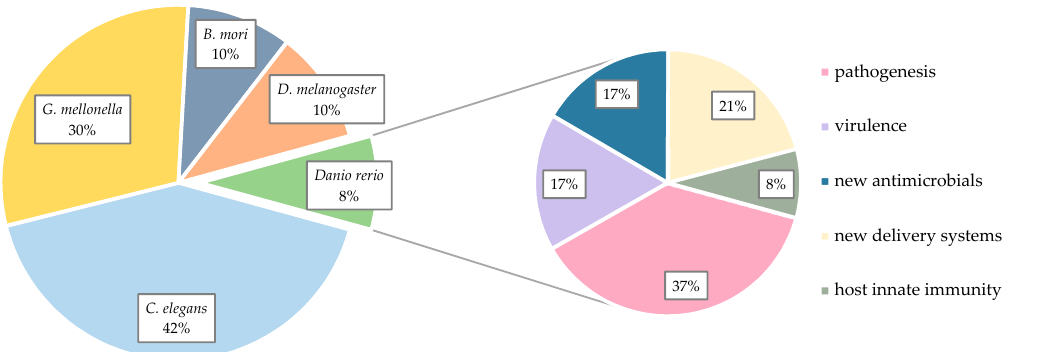
Figure 1. Percentage of different non-mammalian in vivo models used for Staphylococcus aureus infection ( left ) and applications of zebrafish models to study S. aureus infection (right) over the last decade. A PubMed database search was performed to identify studies using invertebrates ( Galleria mellonella , Caenorhabditis elegans , Drosophila melanogaster and Bombyx mori ) and zebrafish embryos/larvae for S. aureus infection models. Studies from January 2011 through January 2021 were included and percentages were calculated based on the total number of publications ( n = 282) in this period (see SI). G. mellonella and C. elegans are the most used models for studying different aspects of S. aureus infection and for assessing the in vivo efficacy of new potential antibiotics. Although zebrafish larvae are prominent models for studies of infectious disease and have been used for a broad range of other microorganisms, there are only relatively few literature reports on the use of this model to study S. aureus infection. The fields of applications of zebrafish models of S. aureus infection are depicted on the right. Most studies were performed with the intention of analyzing the pathogenesis and the virulence of different strains. Moreover, zebrafish larvae seem to be a promising platform for studying the in vivo efficacy of new anti-staphylococcal agents and new delivery systems/routes for already known antibiotics.